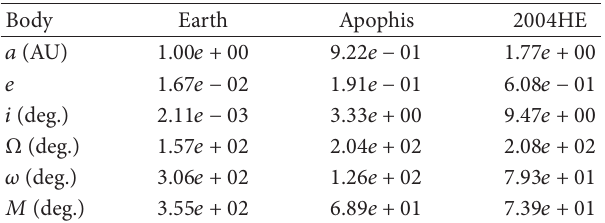
Table 1: Orbital parameters of Earth, Apophis, and 2004HE (Jan. 1, 2012,